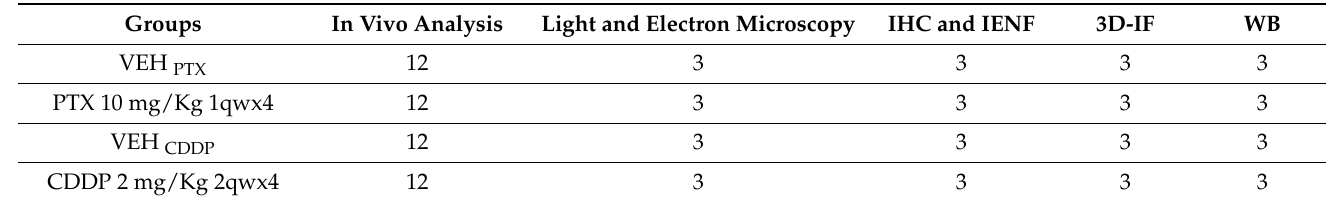
Table 1. Experimental design. The table shows a summary of animals employed for each group, the treatments, and the analysis performed in the study. (VEH, Vehicle; PTX, paclitaxel; CDDP, cisplatin; IHC, immunohistochemistry; IENF, intraepidermal nerve fibers; IF, immunofluorescence; 3D,